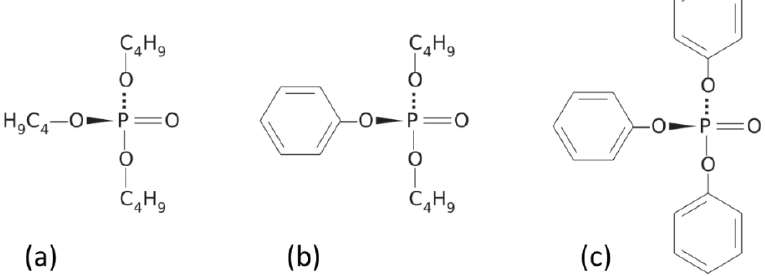
Figure 1. Chemical structure of aircraft certified hydraulic fluids; ( a ) tributyl phosphate; ( b ) di-butyl phenyl phosphate; ( c ) triphenyl phosphate [6].